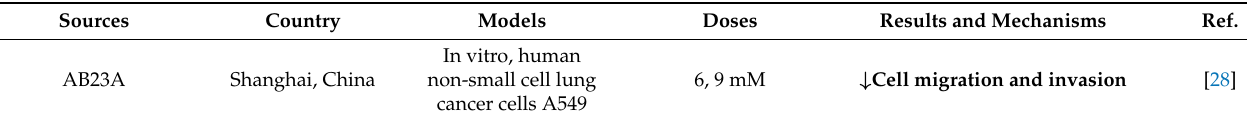
Table 2. Antimetastatic effects and molecular mechanisms of AR and its